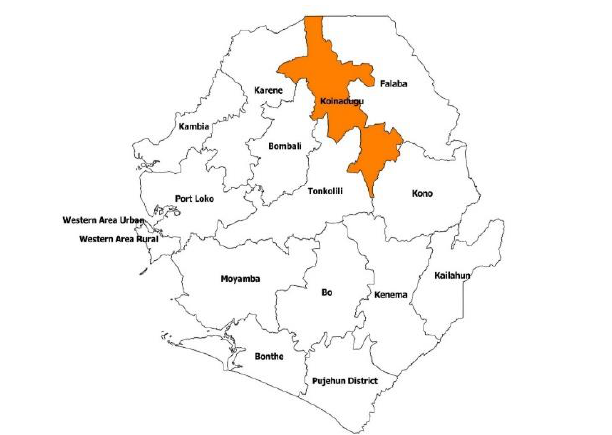
Fig . 1 : Map of Koinadugu District, Sierra